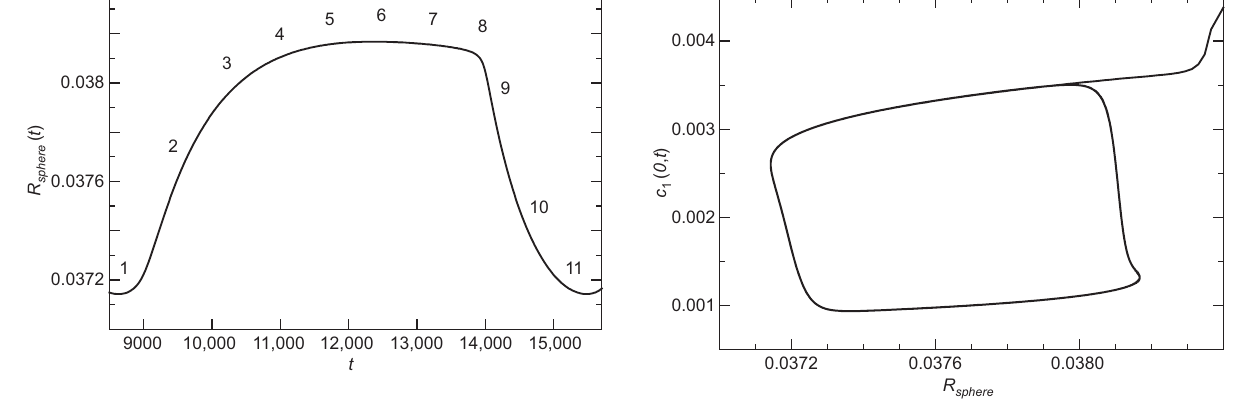
(0, t ) as a function of R ( t ). sphere 1